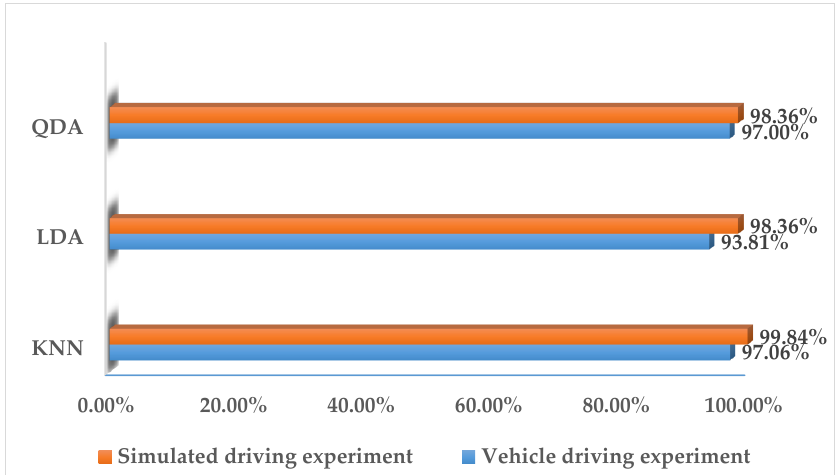
Figure 9. Accuracy of fusion with ECG and EMG signals.